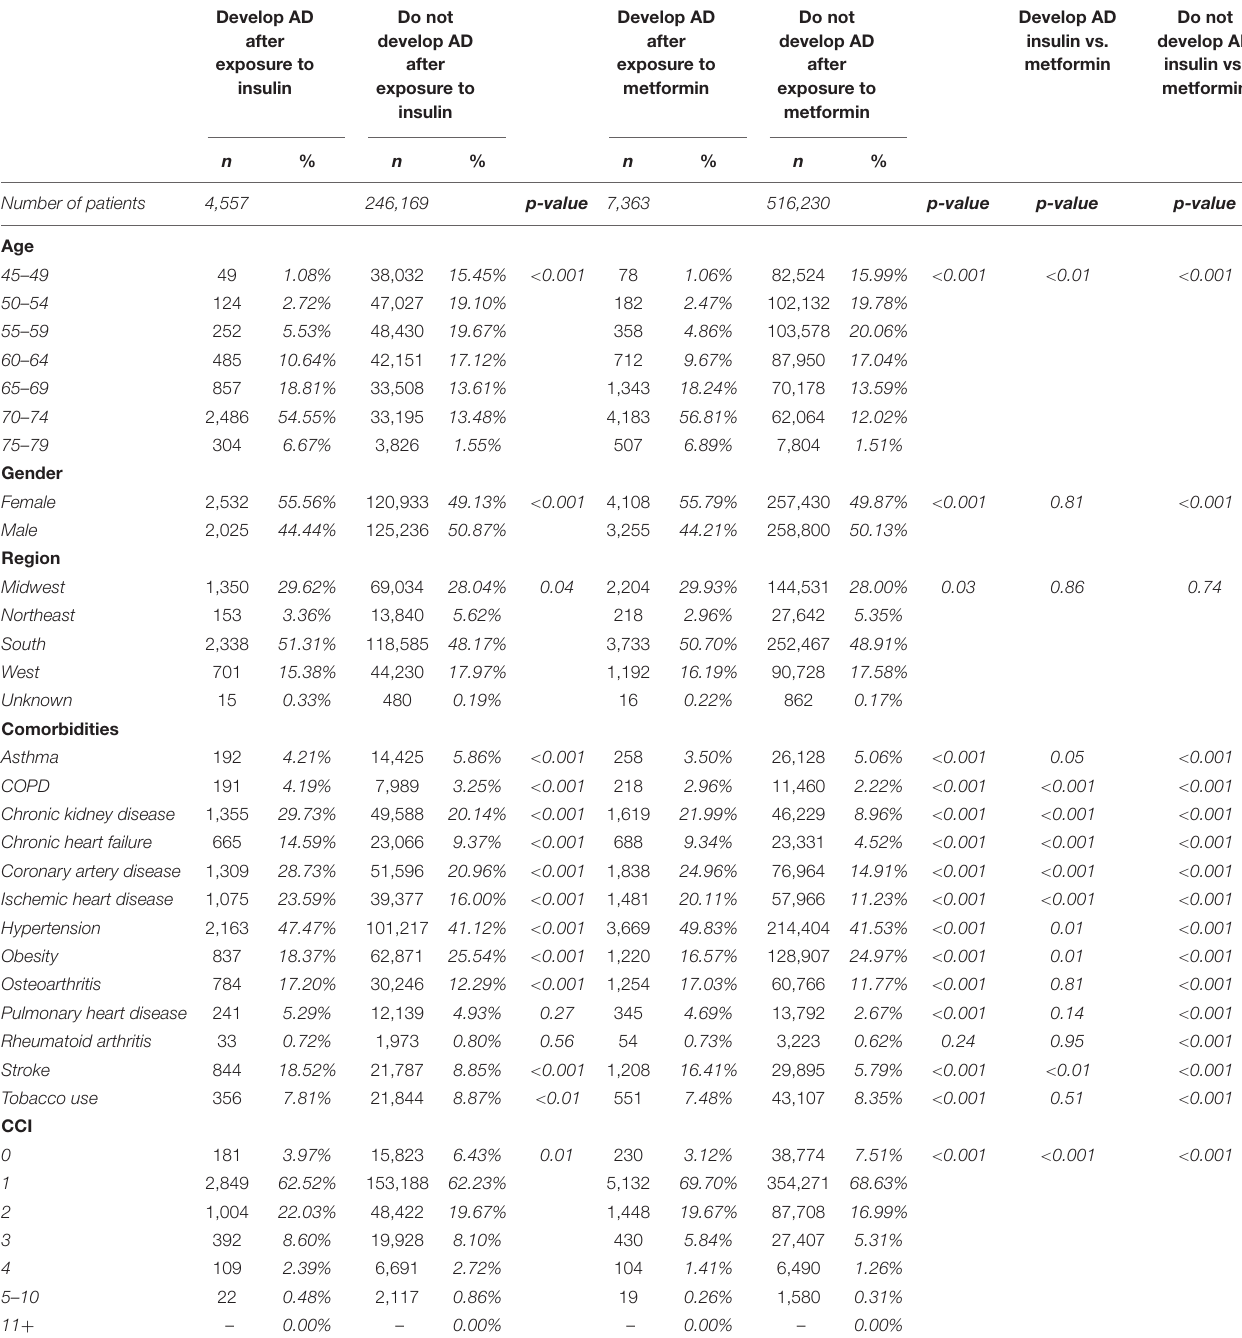
TABLE 8 | Patient demographics and comorbidities in patients who develop and who do not develop AD treated with insulin in comparison with patients treated with metformin.